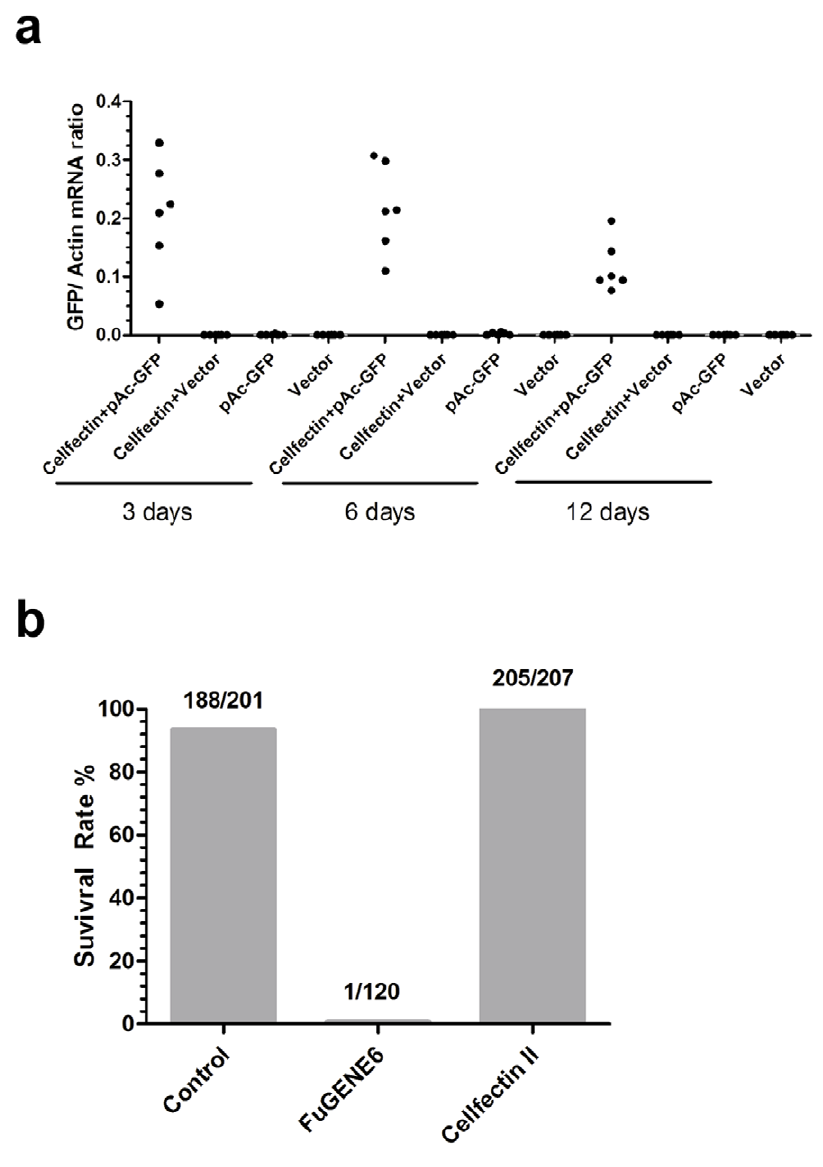
Figure 1. Cellfectin II H enhances GFP mRNA invivo expression in Ae.aegypti . ( a ) Cellfectin II H significantly enhances GFP expression in Ae. aegypti . 200 ng pAc-GFP and the empty vector DNA were microinjected per mosquito. Total RNA was isolated from whole mosquitoes and the samples were decontaminated by Dnase I treatment. The GFP expression was determined by SYBR Green H QPCR, and normalized using Ae. aegypti actin (AAEL011197) . Each dot represents 1 mosquito. The experiment was repeated twice with similar results. ( b ) Cellfectin II H does not influence mosquito survival. Each liposome reagent mixed with vector DNA was microinjected into the mosquito (200 ng DNA each mosquito). The mosquito survival was recorded at 6 hours after materials inoculation. Control mosquitoes were treated with PBS. The number at the top of bar represents the number of live mosquitoes/total mosquitoes in a treatment.